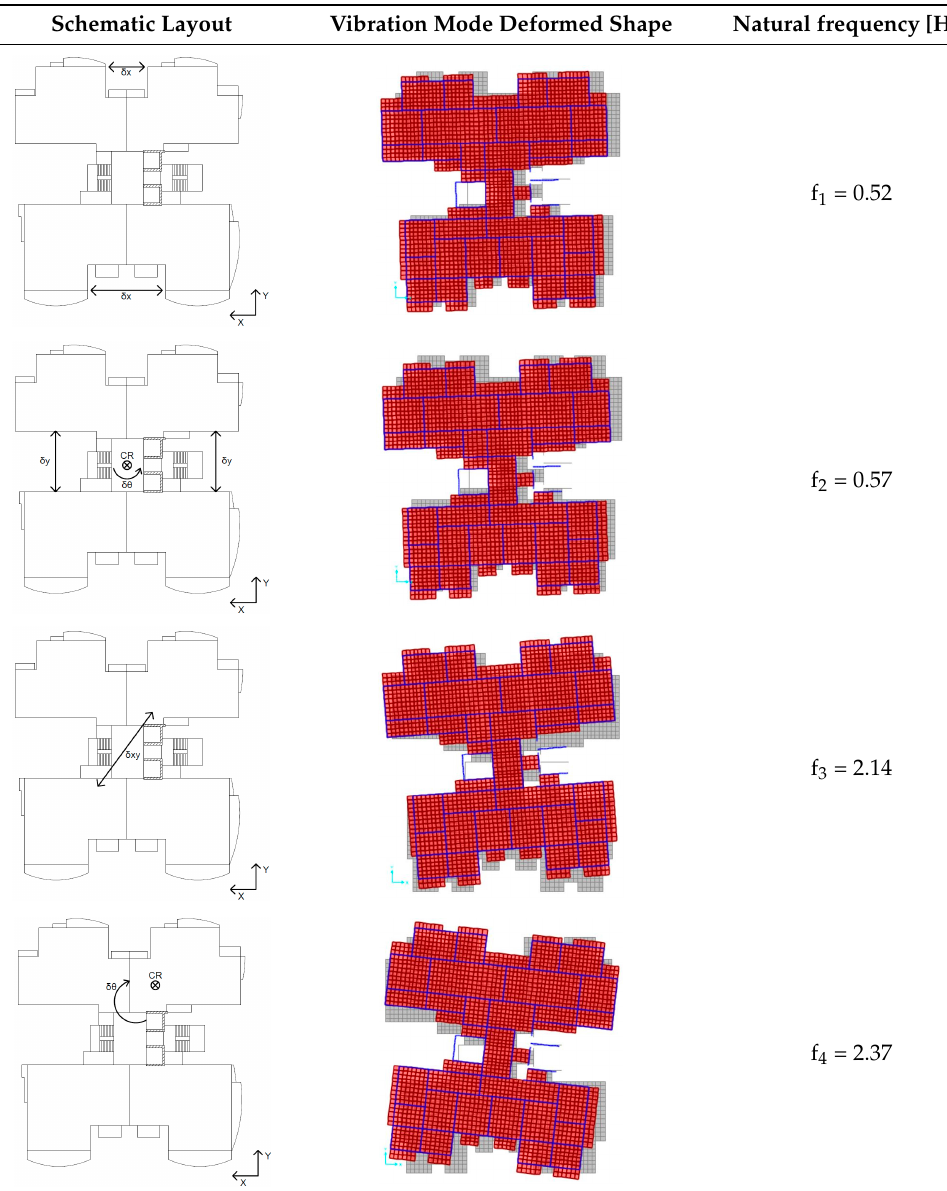
Table 3. Modal analysis results: model without infill masonry walls (Model 1).